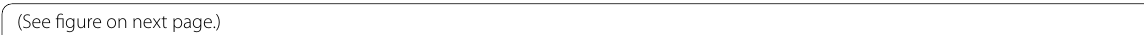
(Fig. 1c): when, in at least one plane, the distance between the margins of the disc material dislocated outside the original discal space is greater than the distance between the edges of the base of the